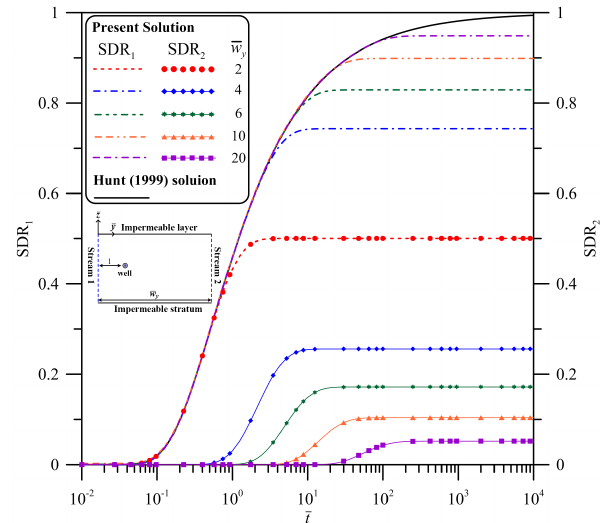
Figure 6. Temporal SDR distribution curves predicted by Eqs. (52) and (53) with γ = 0 for confined aquifers when w y = 2 , 4 , 6 , 10, and